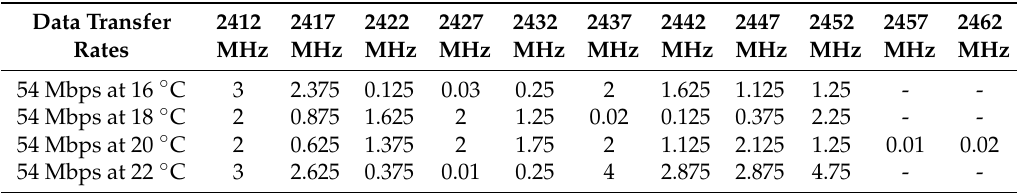
Table 19. Calculation of residuals for OFDM at 54 Mbps.